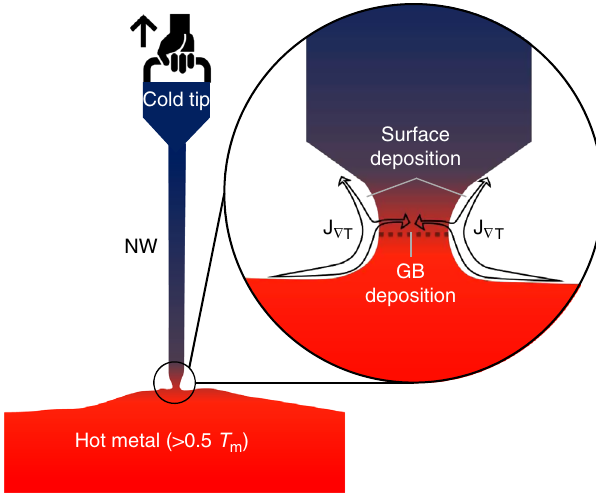
Fig. 1 Schematic illustration of making single-crystalline nanowire by hot drawing. The physical process occurring near the neck-shaped ligament with a grain boundary (GB) is shown in the magni fi ed